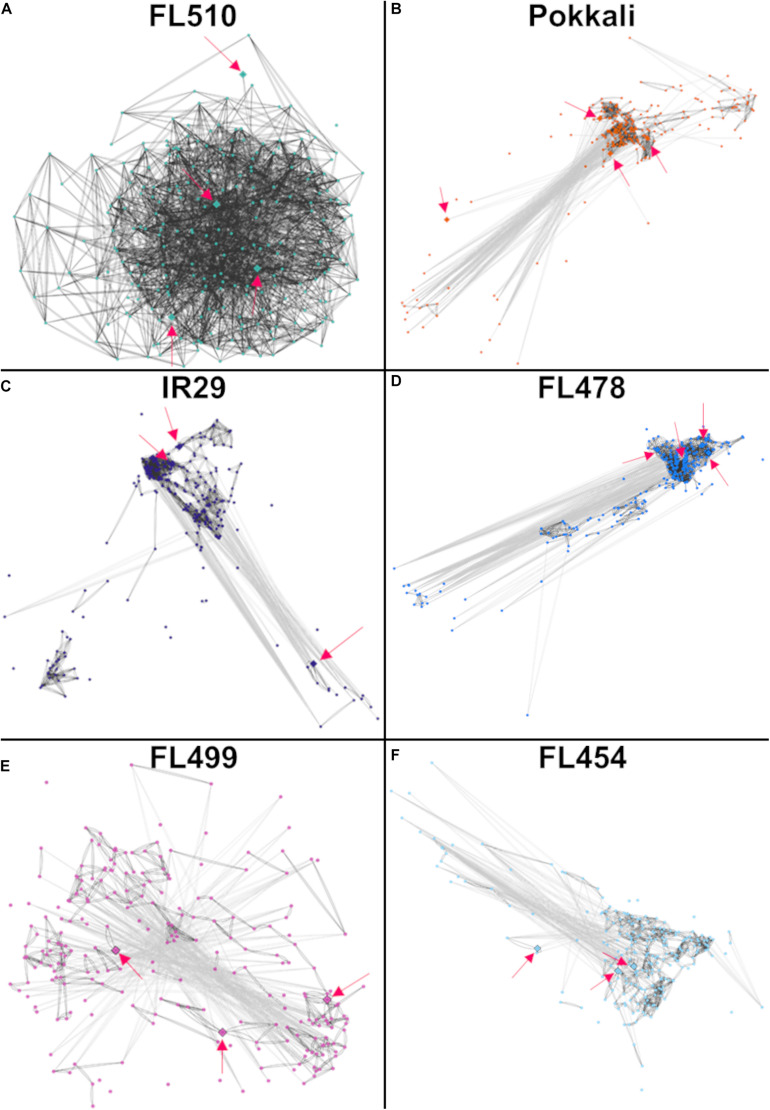
Models of the putative cytokinin-mediated transcriptional network comprised of 244 genes that were upregulated in FL510 as shown in Figure 5. Co-expression networks were constructed by Pearson correlation coefficients (PCC). Edges represent r values of at least -0.95 or 0.95. Dark gray lines indicate direct co-expression between two genes (nodes) and light gray lines indicate reverse co-expression. The distances between nodes are also reflective of the relationship between genes, with lower co-expression values having larger distances. Pink arrows indicate the position of the identified cytokinin-related genes, which are also denoted as diamond nodes. (A) The network in FL510 does not show negative co-expression between nodes. In contrast, the network appeared disjointed in (B) sensitive parent IR29, (C) tolerant donor parent Pokkali, and (D) tolerant FL478 with only partial conservation of the network connectivity observed in FL510. (E) The network in the super-sensitive FL499 is extensively fragmented, indicating a lack of functional coordination. (F) The network in the sensitive FL454 shows a different coordinated cluster that formed from their coordinated downregulation at 24 h. The inferior genotypes excluded one cytokinin-related genes (different in each genotype) as potential hub, further illustrating the fragmented nature of such networks relative to FL510.